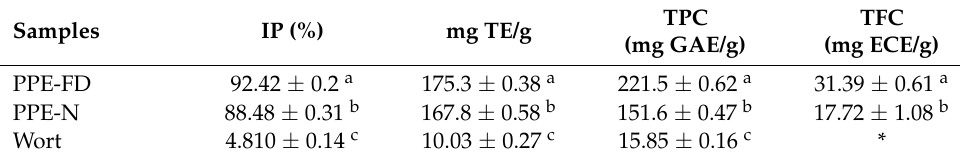
Table 1. Antioxidant capacity of the